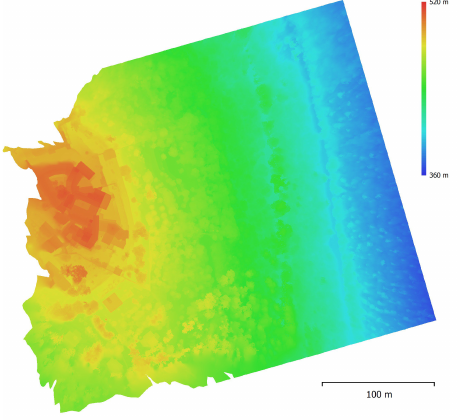
Figure 6 . Digital Surface Model of the area.